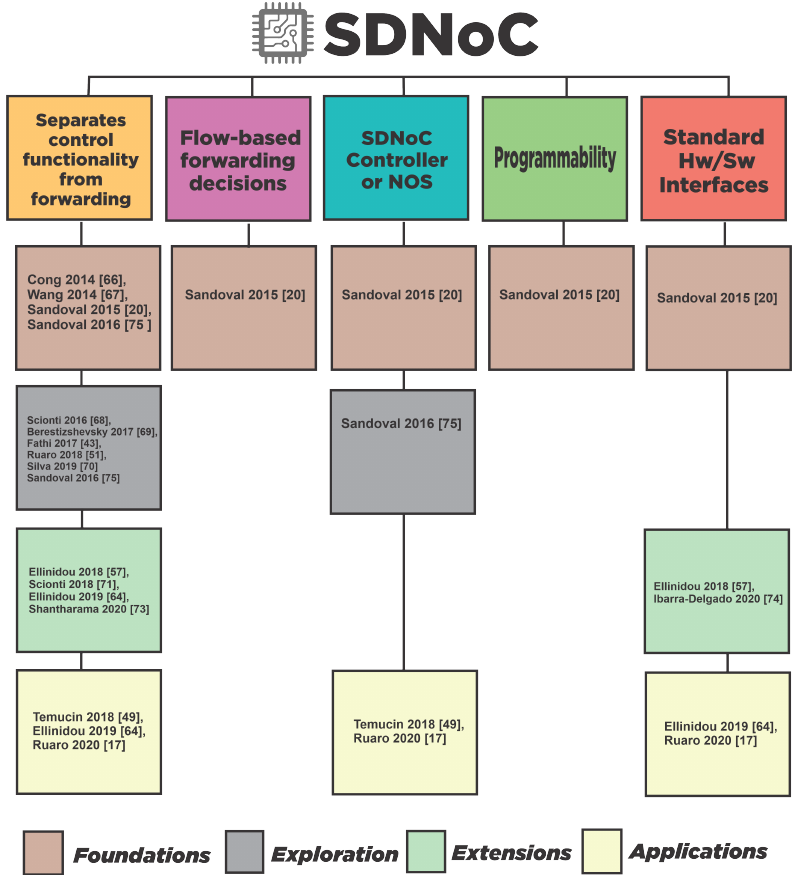
Figure 8. Literature classification regarding the SDNoC desired features (columns) and chronological stages (colors at the